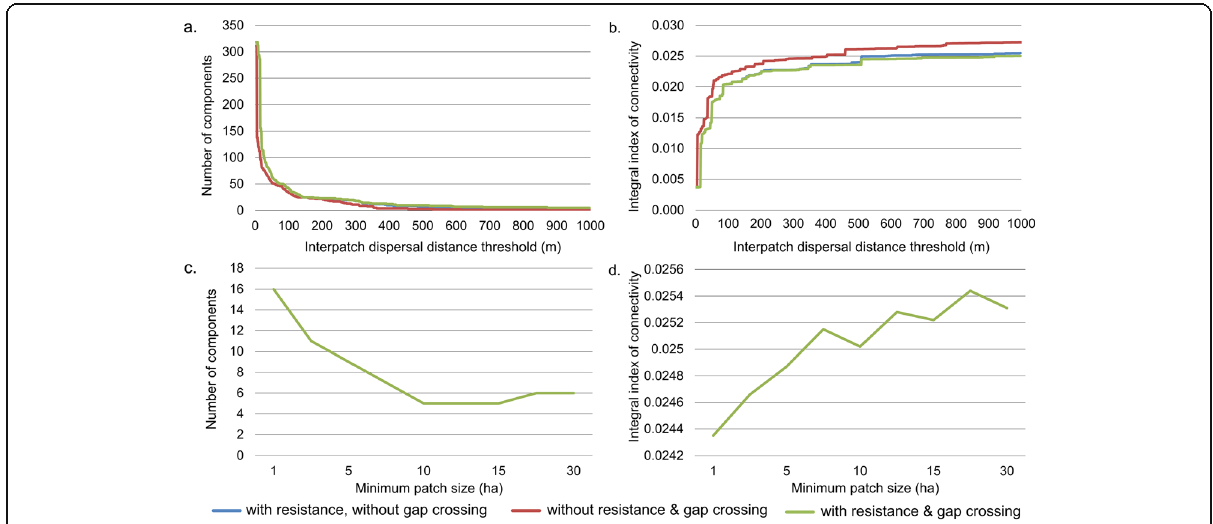
Fig. 6 Number of components and integral index of connectivity versus interpatch dispersal distance threshold a , b and minimum patch size c , d . a, b Compare model scenarios with resistance, without resistance and without the gap crossing layer, while c, d connectivity shows that the metrics are negatively and positively correlated to minimum patch size